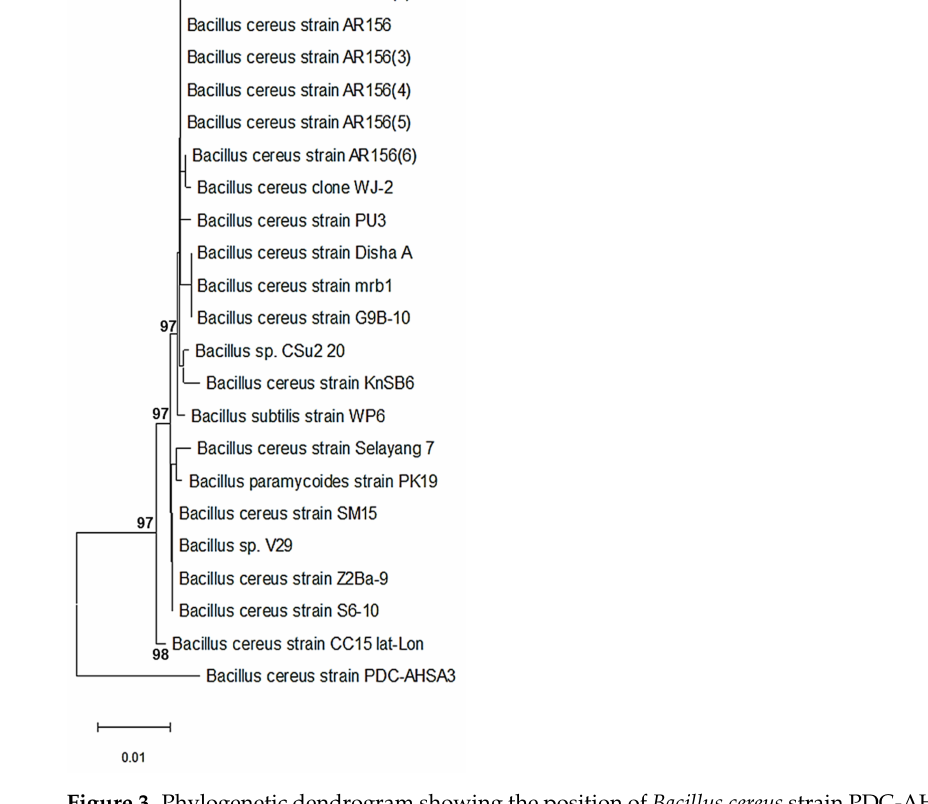
Figure 3. Phylogenetic dendrogram showing the position of Bacillus cereus strain PDC-AHSA3 among phylogenetic